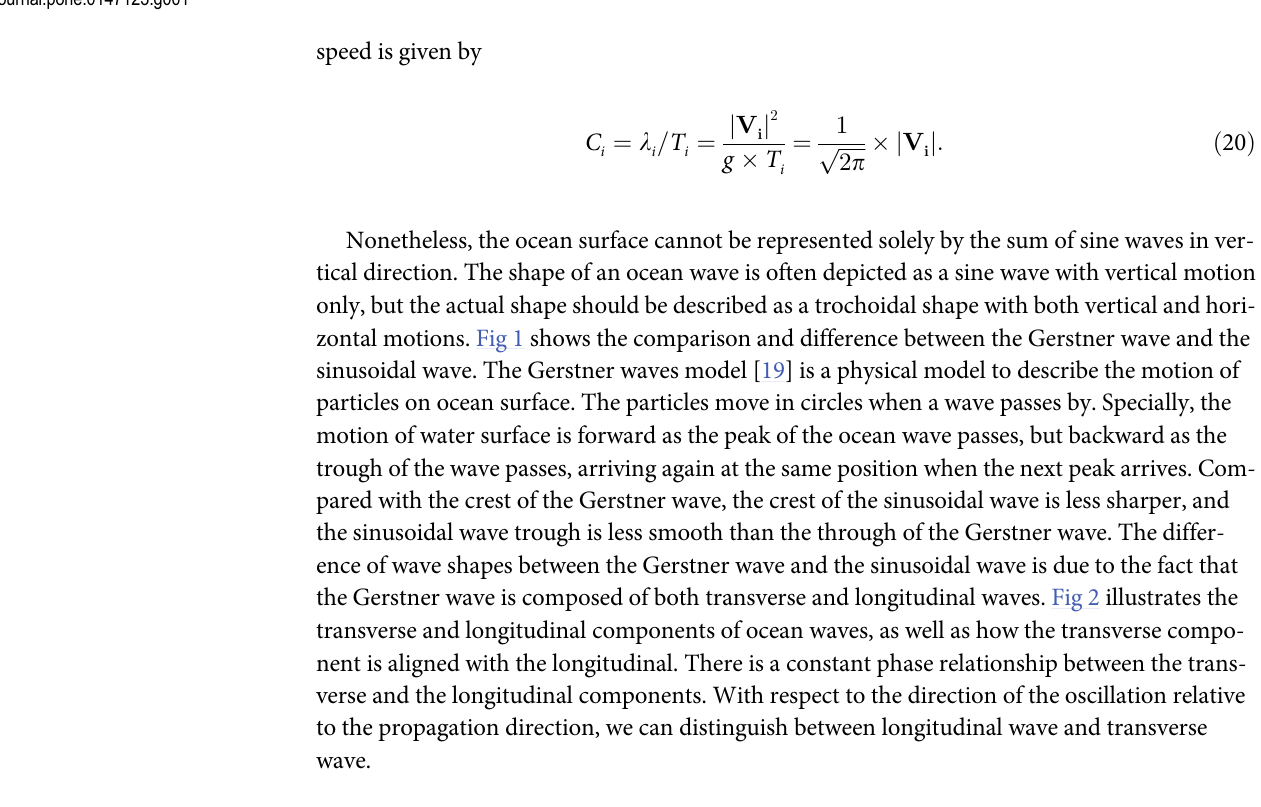
Fig 1. Comparison between two-dimensional Gerstner waves and sinusoidal wave. (A) Gerstner waves with longitudinal component. (B) Sinusoidal wave without longitudinal component.